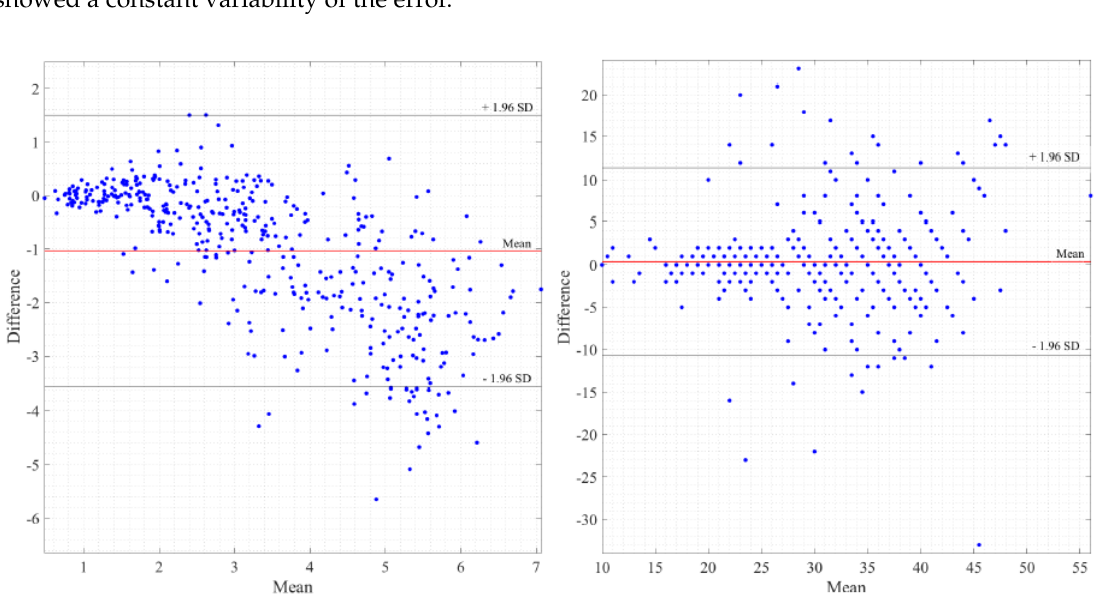
Figure 11. Absolute error box plots, all subjects, different intensities during exercise, all parameters: normalized amplitude ( A ), respiratory rate ( B ), normalized minute ventilation ( C ) and duty cycle ( D ). The intensities shown are the following: low (L), medium (M), high (H), maximum (IMAX), recovery phase 1 (RP1), recovery phase 2 (RP2).